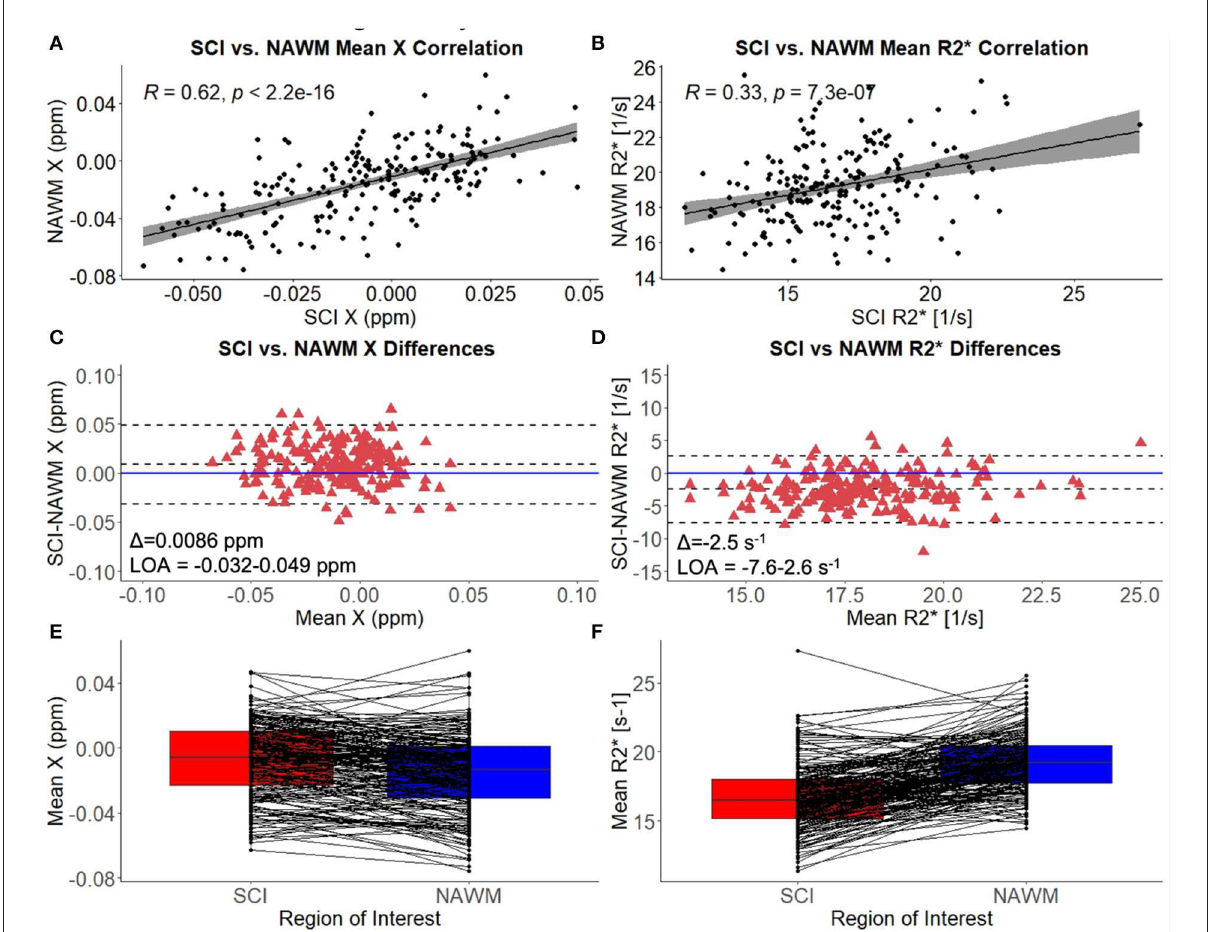
FIGURE3 SCI vs. NAWM χ and R * 2 . (A) Correlation between the mean susceptibility ( χ ) in segmented silent cerebral infarcts (SCI) and contralateral normal appearing white matter (NAWM). (B) Correlation between mean SCI and NAWM R * 2 . (C) Bland-Altman analysis of SCI-NAWM χ differences. The mean bias ( 1 ) is positive suggesting that on average the SCI are less diamagnetic than NAWM. (D) Bland-Altman analysis of SCI-NAWM R * 2 differences. The mean bias is negative indicating that on average the SCI have lower R * 2 than NAWM. Bland-Altman plots also show the limits of agreement (LOA) and the horizontal blue line is located at SCI-NAWM = 0. (E) Boxplot comparing mean SCI and NAWM χ , showing that mean χ is significantly elevated in SCI. (F) Boxplot showing that mean R2* is significantly reduced in SCI relative to